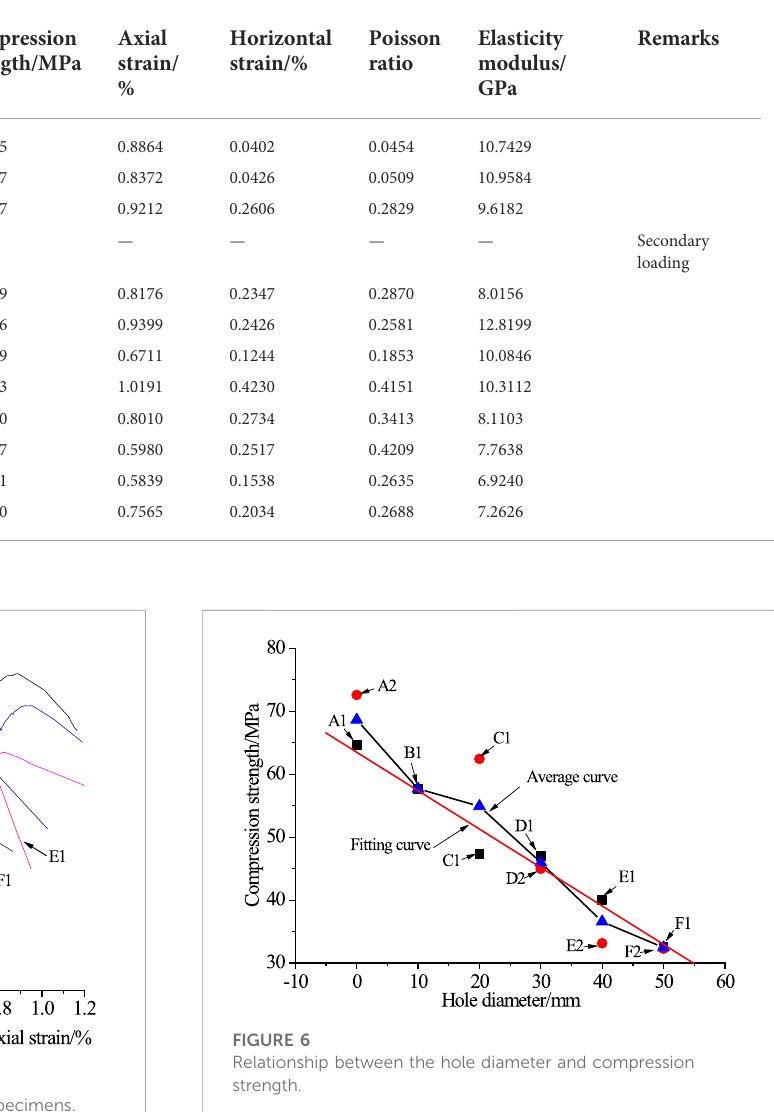
TABLE 1 Uniaxial compression data.